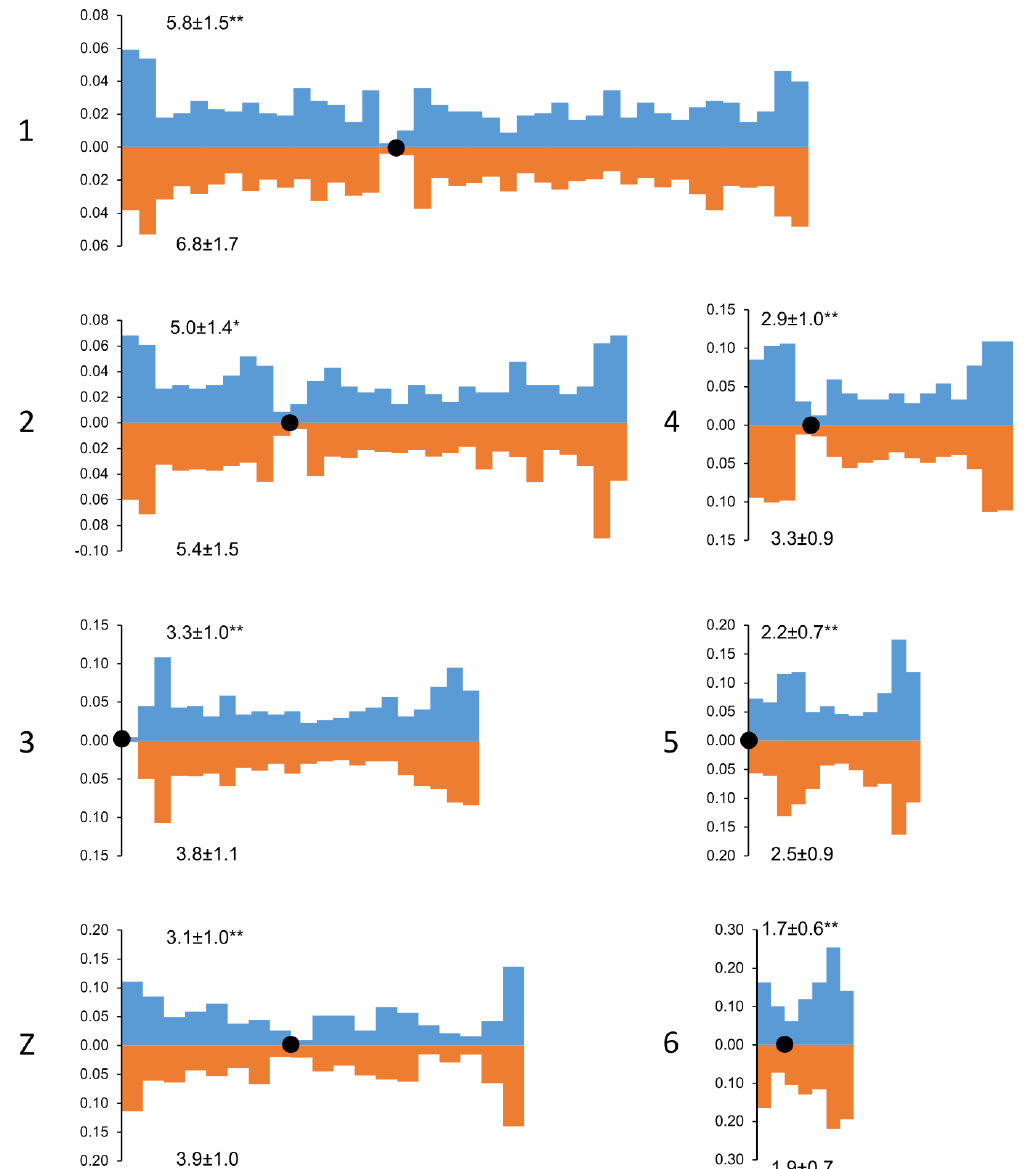
Figure 2. Distribution of MLH1 foci along the macrochromosomes of Russian Crested (blue columns) and Russian White (orange columns) roosters. On the x axis: positions of the MLH1 foci on the chromosomes relative to the centromere (black circle). Each interval is the proportion of the average length of each SC and is approximately 1µm in length. On the y axis: the proportion of MLH1 foci within each interval. The numbers to the left of the y axis stand for chromosome numbers; the numbers above and below each graph show the average number of MLH1 foci at a given chromosome of a given breed. Differences between the breeds in the average number of MLH1 foci are significant (Student’s t test ∗∗ : p < 0 . 01; ∗ : p < 0 .